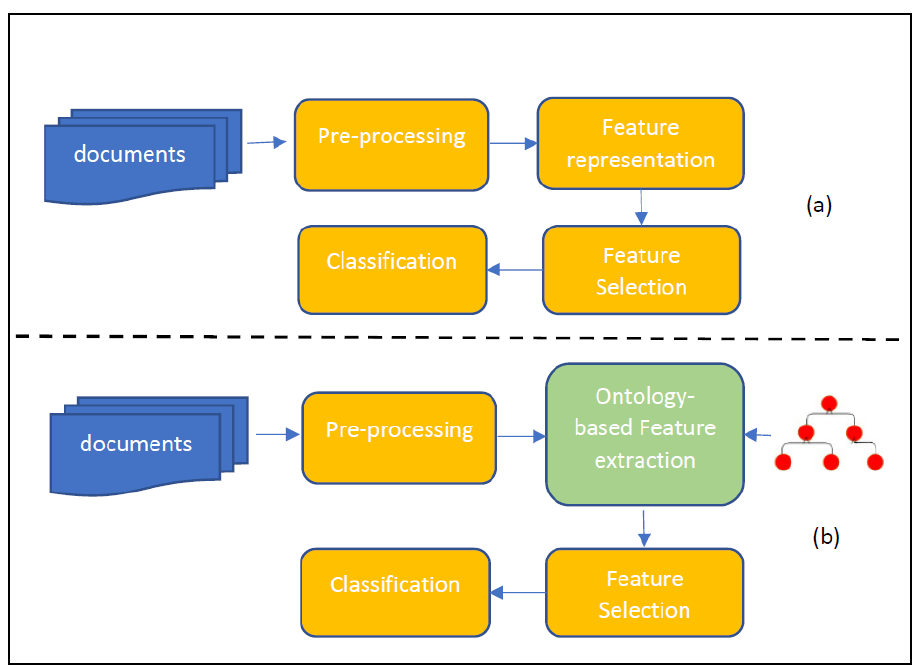
Figure 2. ( a ) Standard feature selection. ( b ) Ontology-based feature